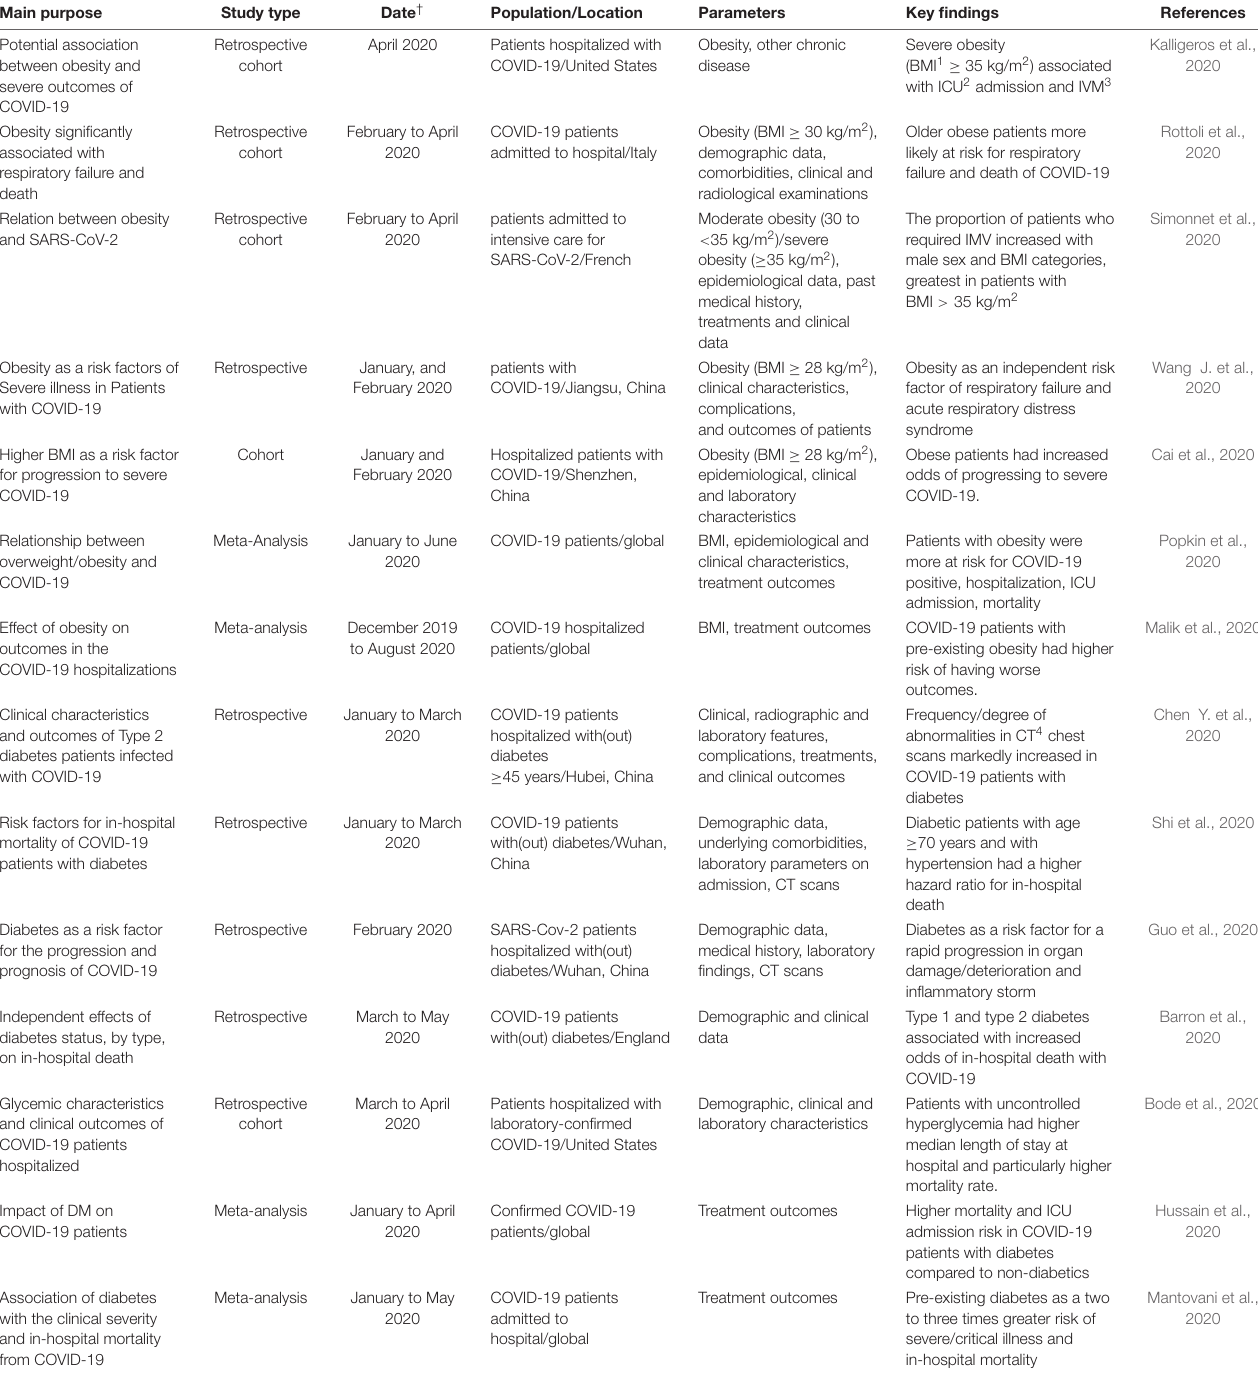
TABLE 1 | Relation between DM and obesity and risk of COVID-19-related